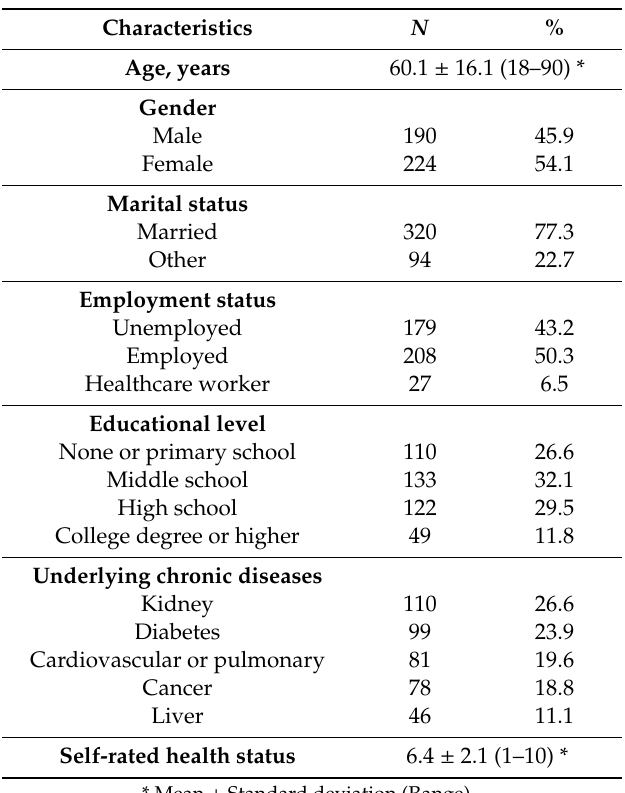
Table 1. Socio-demographic characteristics of the study